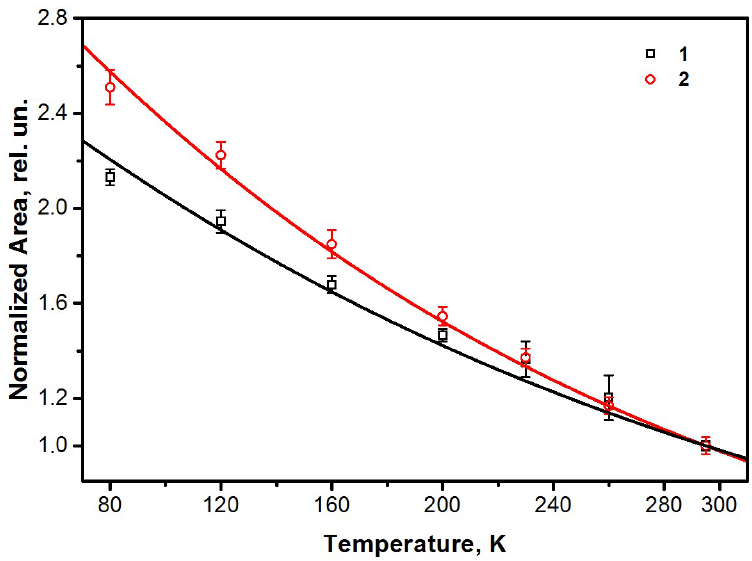
Figure 9. The temperature dependencies of Mössbauer absorption area for 1 (black) and 2 (red). The dots are experimental data, whereas solid lines are best fit results.